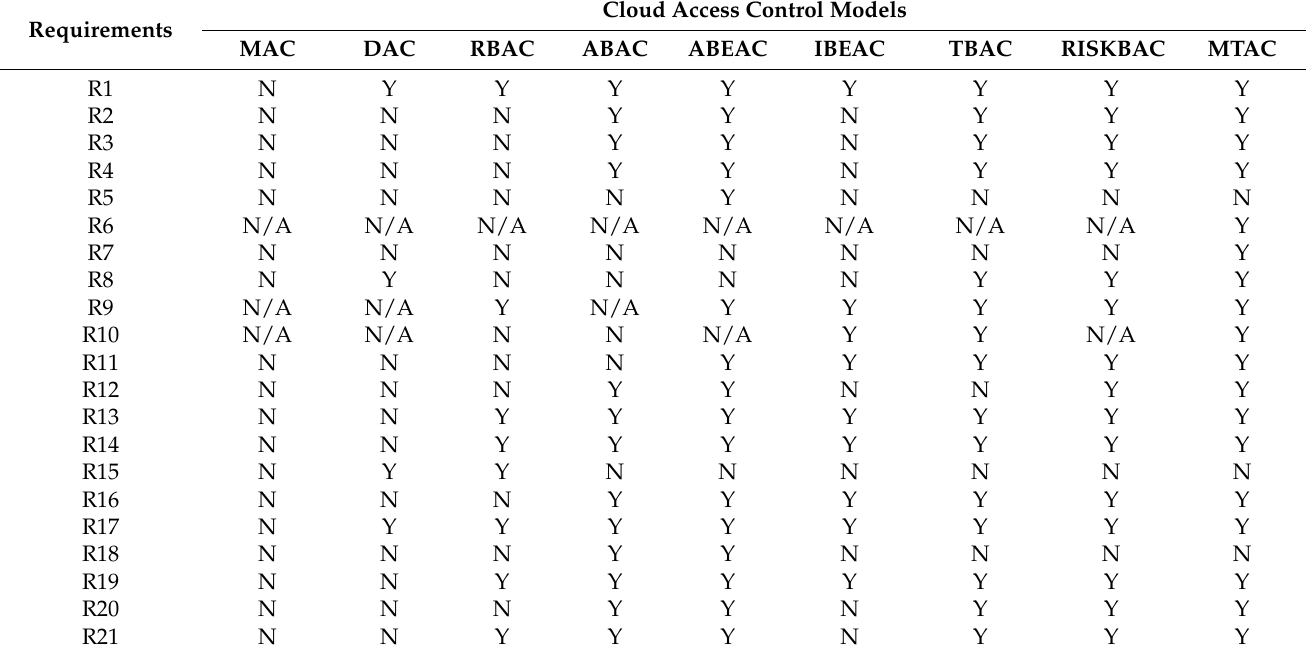
Table 3. Access control mechanisms and requirements included in the review, N: no, Y: yes, N/A: not